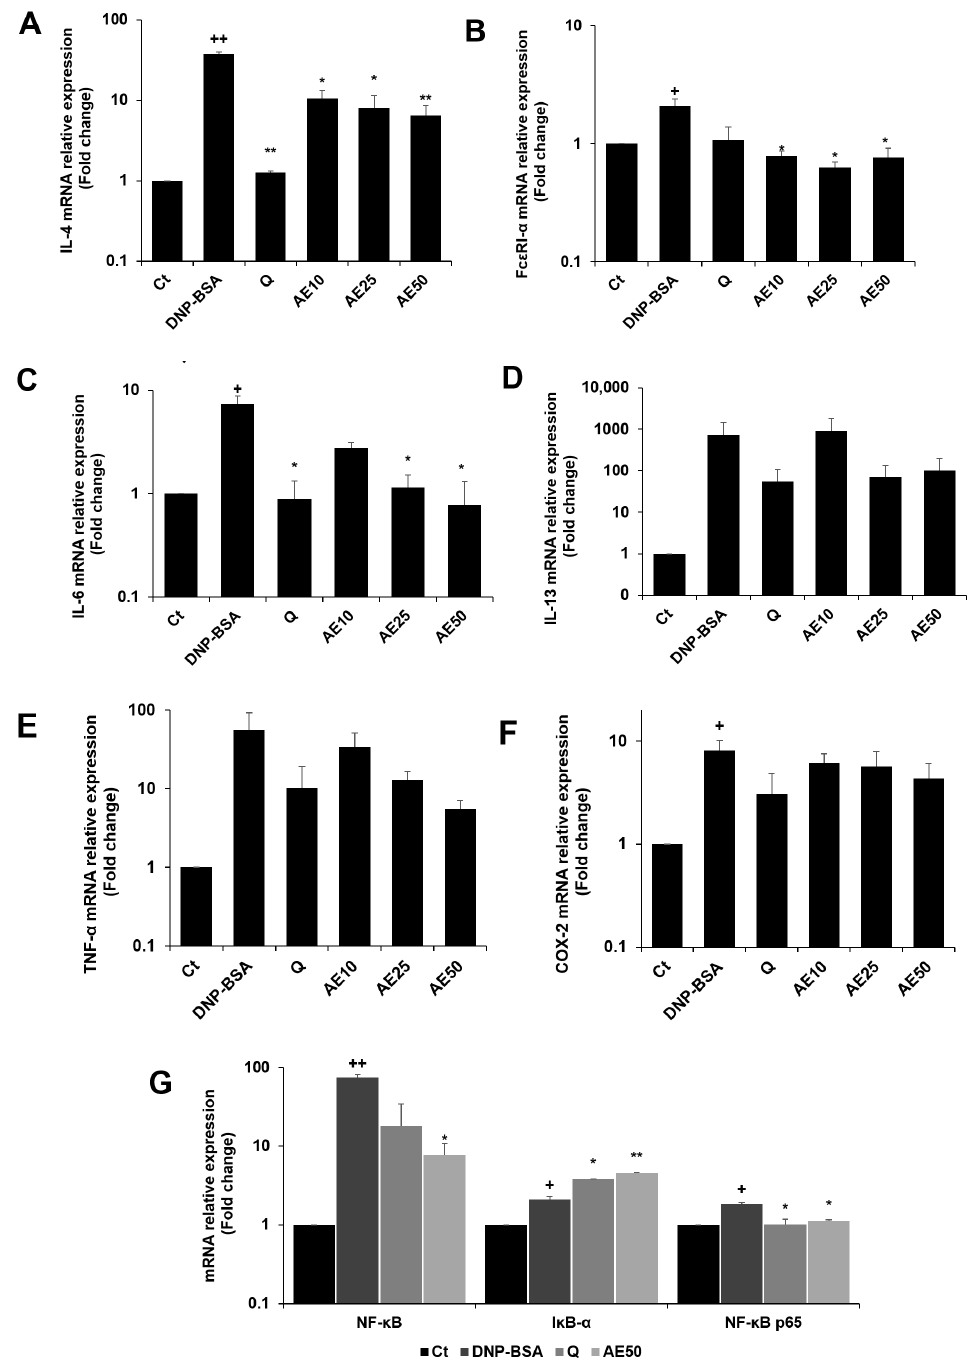
Figure 7. Effects of the amber extract on cytokine- and NF- κ B-related gene expressions of RBL-2H3 cells stimulated by DNP-BSA for 1 h. ( A ) The mRNA expression levels of IL-4. ( B ) The mRNA expression levels of Fc ε RI- α . ( C ) The mRNA expression levels of IL-6. ( D ) The mRNA expression levels of IL-13. ( E ) The mRNA expression levels of TNF- α . ( F ) The mRNA expression levels of COX-2. ( G ) The mRNA expression levels of NF- κ B. I κ B- α , and NF- κ B p65 were measured by qRT-PCR. Data are expressed as mean ± SEM (+ p < 0.05, ++ p < 0.01 vs. control, * p < 0.05, ** p < 0.01 vs. DNP-BSA).